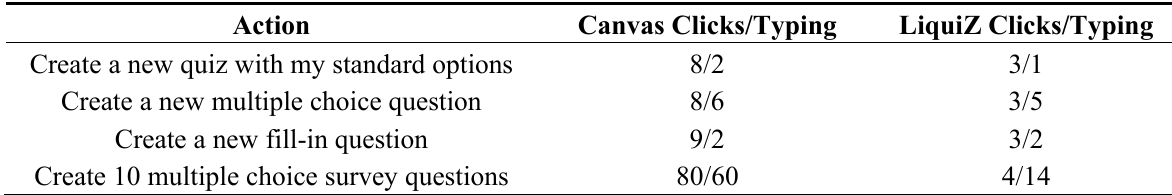
Table 4. Operations count: Canvas vs. LiquiZ